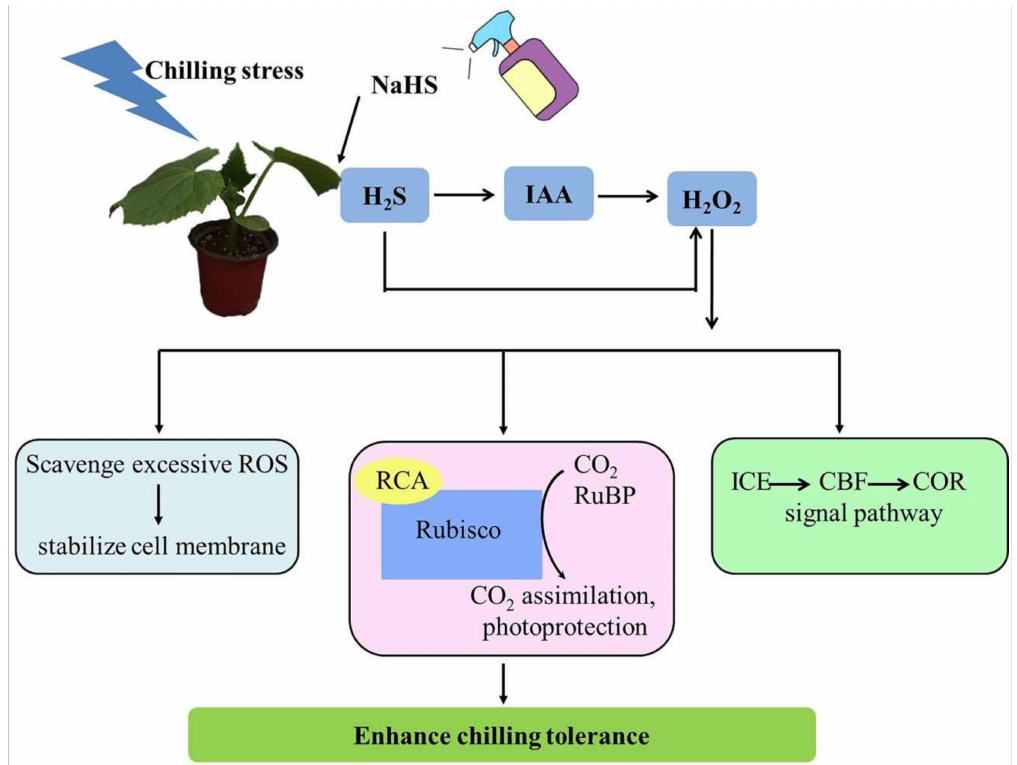
Figure 10. A proposed model for the role of IAA and H 2 O 2 in H 2 S-induced chilling tolerance in cucumber. Chilling induces the accumulation of H 2 S in the plants. H 2 S induced by chilling promotes IAA generation, triggers H 2 O 2 accumulation, and subsequently increases chilling tolerance by scavenging excessive ROS, improving CO 2 assimilation and photoprotection, and upregulating the levels of cold-responsive